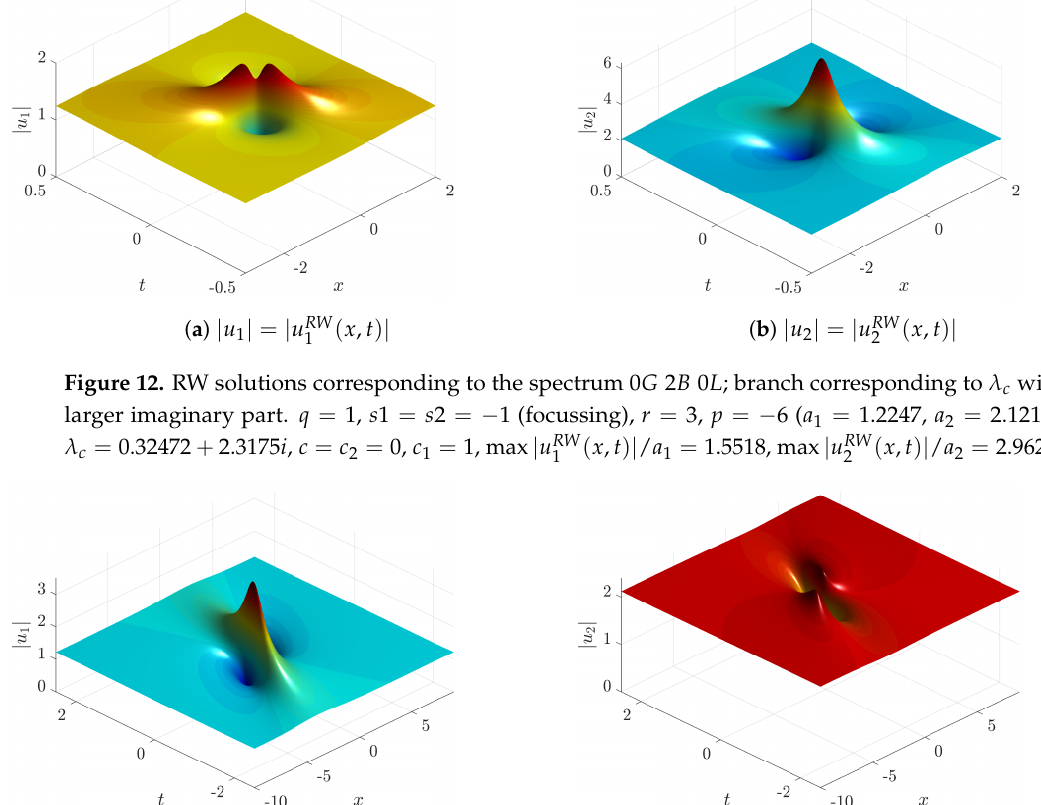
Figure 13. RW solutions corresponding to the spectrum 0 G 2 B 0 L , branch corresponding to λ c with smaller imaginary part. q = 1, s 1 = s 2 = − 1 (focussing), r = 3, p = − 6 ( a 1 = 1.2247, a 2 = 2.1213); λ c = 0.42528 + 1.7437 i , c = c 2 = 0, c 1 = 1, max | u RW